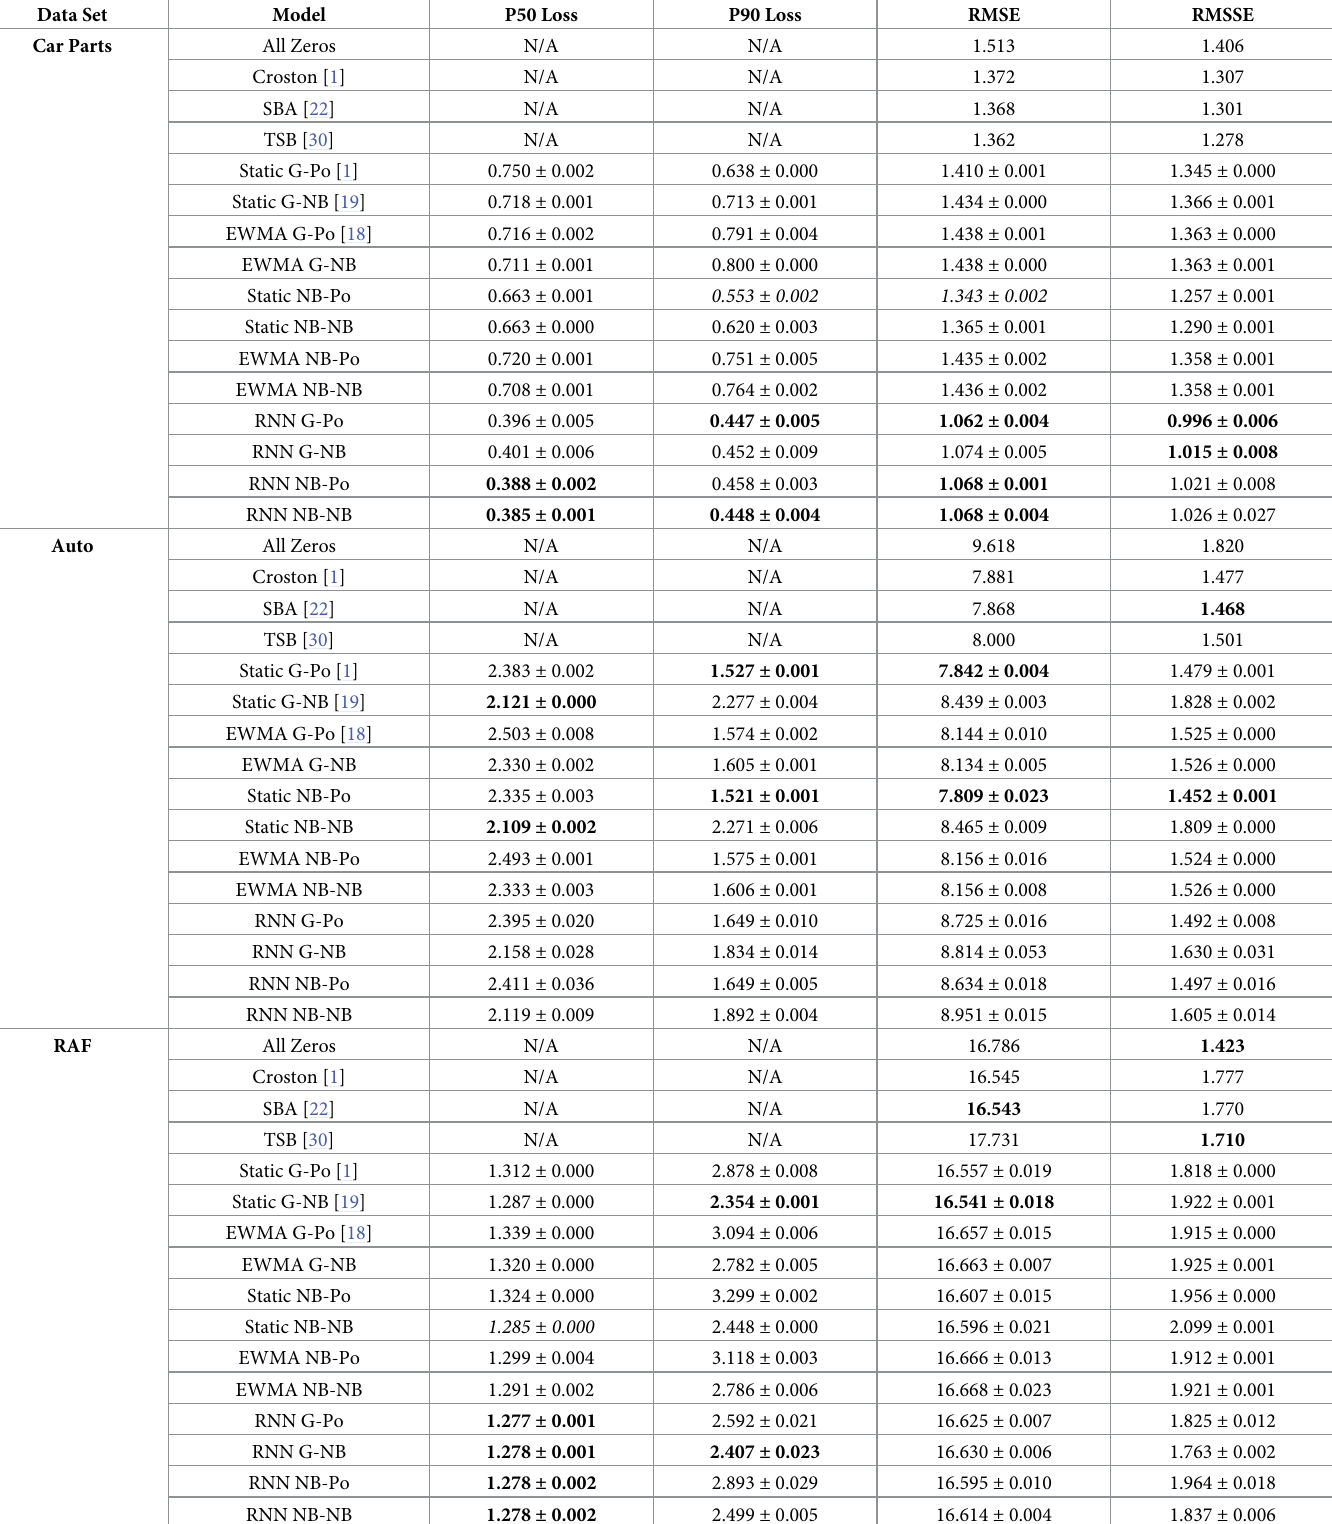
Table 6. Experiment results for discrete-time models with Car Parts, Auto, and RAF data sets. Data